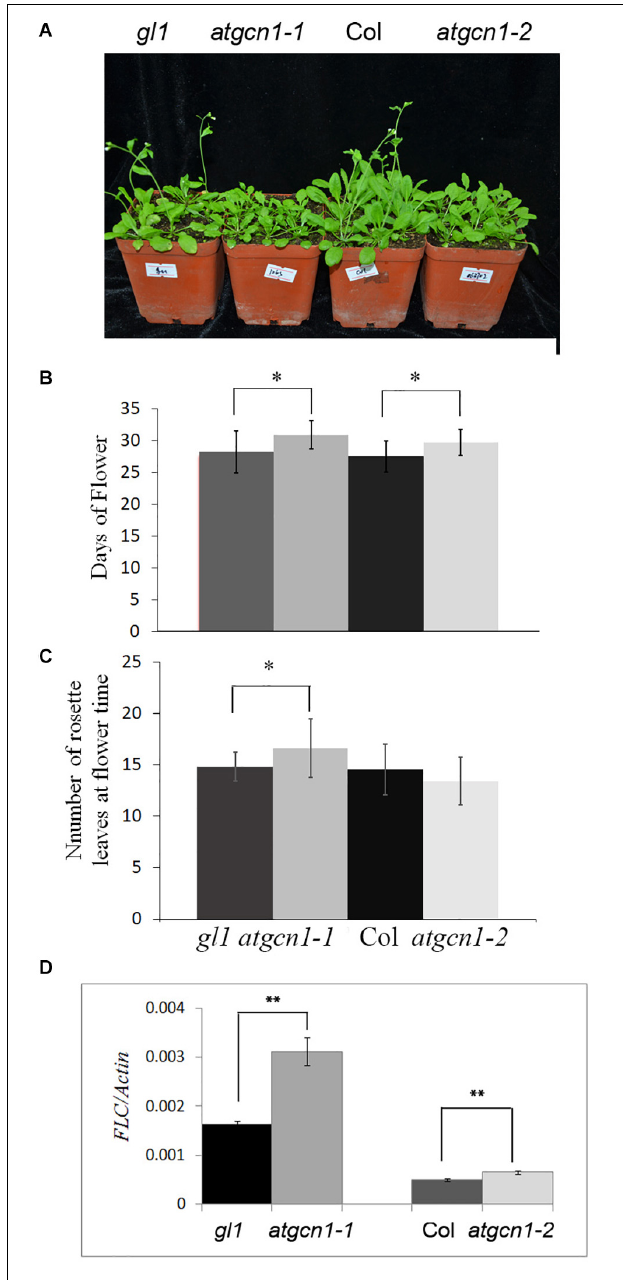
FIGURE 1 | Early flowering of atgcn1-1 and atgcn1-2 in soil. (A) The flowering phenotype of atgcn1-1 and atgcn1-2 in soil. (B) The day statistics of flower time. (C) The number statistics of rosette leaves at flower time. (D) The expression of FLC is higher in atgcn1-1 and atgcn1-2 than in WT. Statistical t -tests were performed. Single asterisk indicates significant difference with a p -Value < 0.05. Double asterisks indicate a significant difference with a p -Value < 0.01. Experiments were repeated three times with similar results